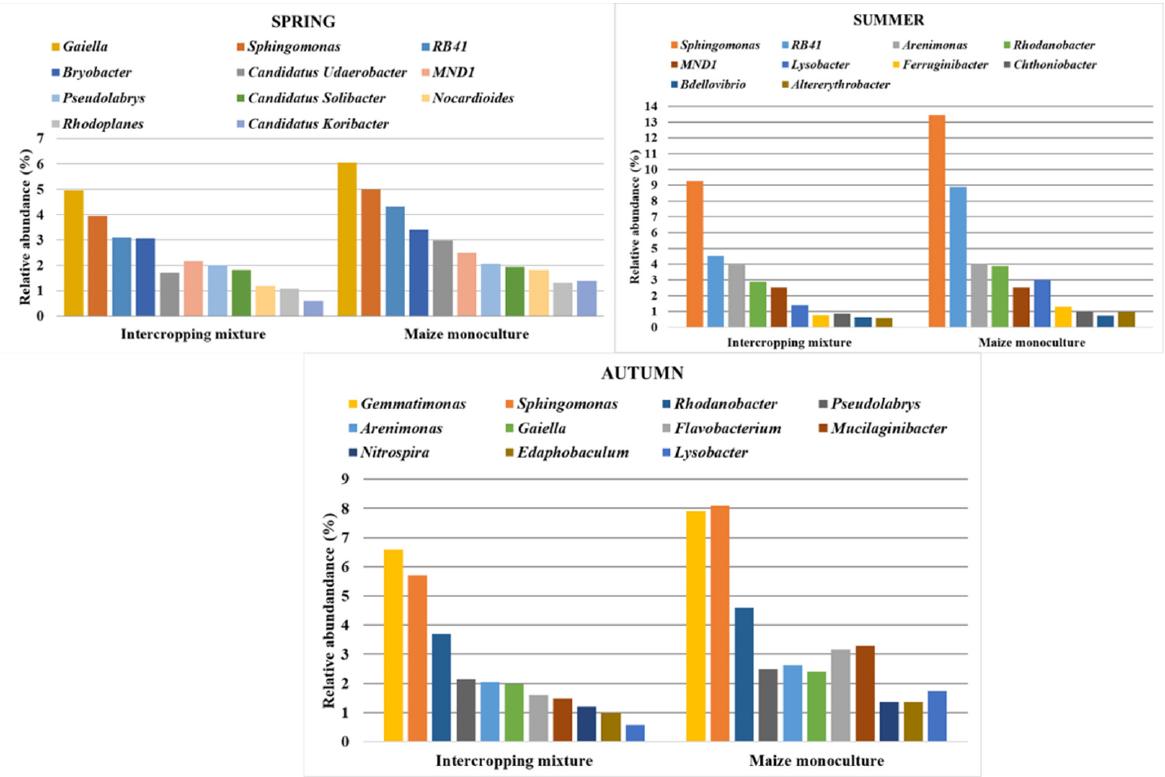
Figure 8. Bacterial genera with resistance to maize monoculture in spring, summer, or autumn . Eleven genera of bacteria were characterized in the spring, with the following pre- dominant genera: Gaiella (4.96% and 6.04% for K20 and K21), Sphingomonas (3.95% and 4.99%), and RB41 (3.09% and 4.33%). The highest abundance was observed in summer when 10 bacterial genera were distinguished. The most representative bacterial genera in this respect were Sphingomonas (9.27% and 13.45% for K20 and K21), RB41 (4.50% and 8.90% for K20 and K21), and Arenimonas (3.95% and 4.03%). In autumn, 11 bacterial genera were identified, with the dominance of Gemmatimonas (6.59%) in the K20 field and Sphingomonas (8.11%) in the K21 field. Interestingly, the genus RB41 , which was highly abundant in the investigated soils in spring and summer, was not detected in